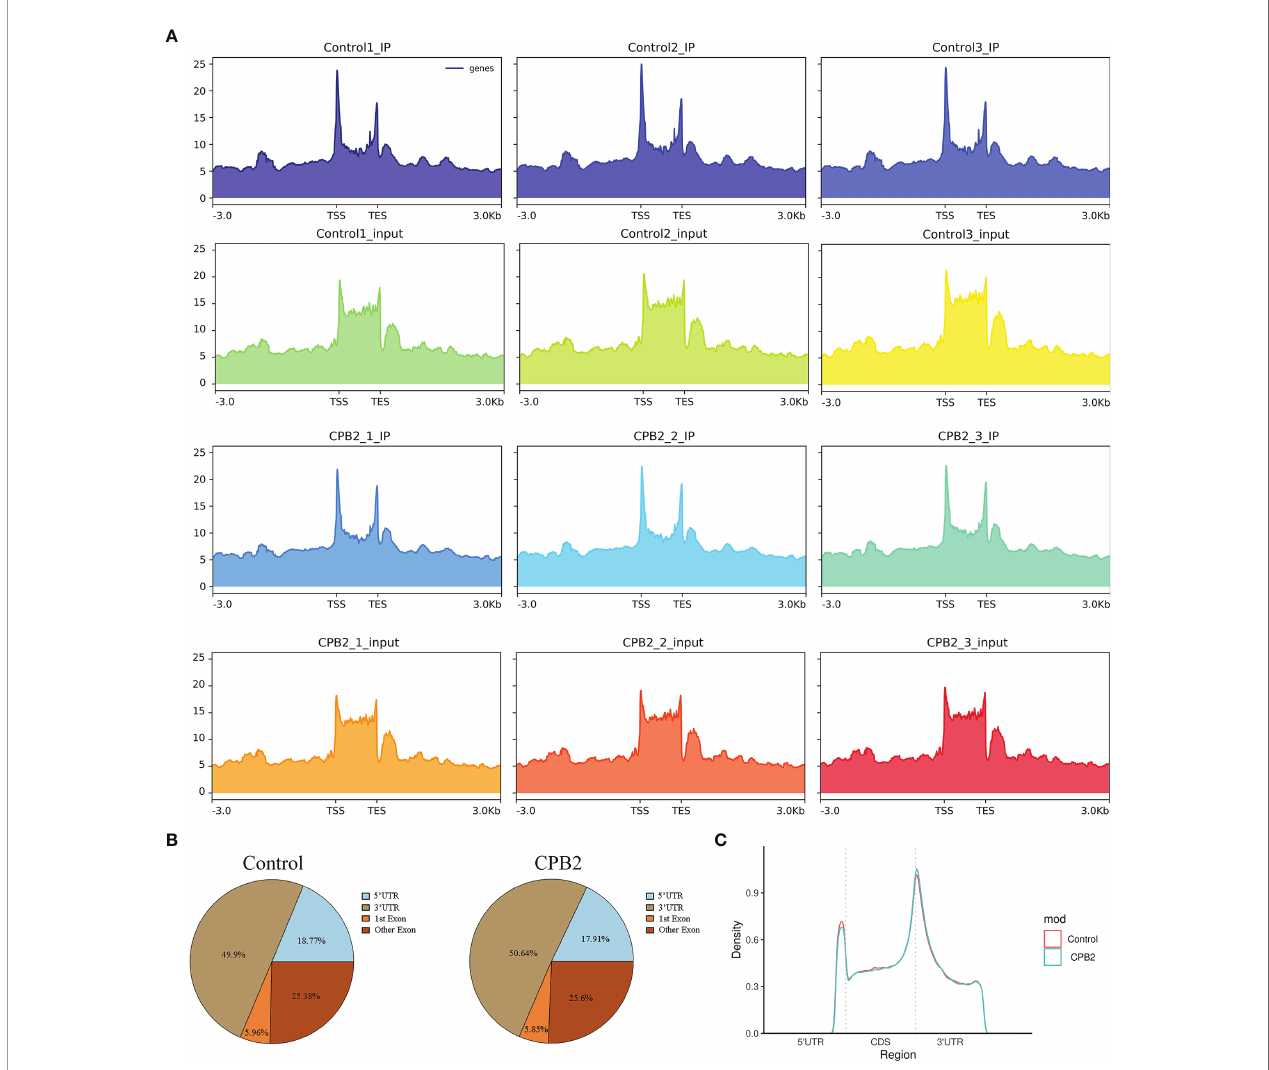
FIGURE 2 | General features of IPEC-J2 cells m6A methylation. (A) The enrichment of peaks near the gene transcription start site. (B) The position distribution of m6A peaks on gene functional elements. (C) The m6A peak density along a